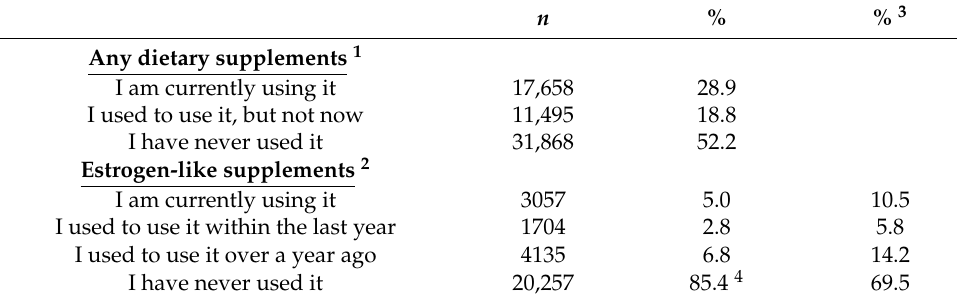
Table 2. The prevalence of dietary supplement use.